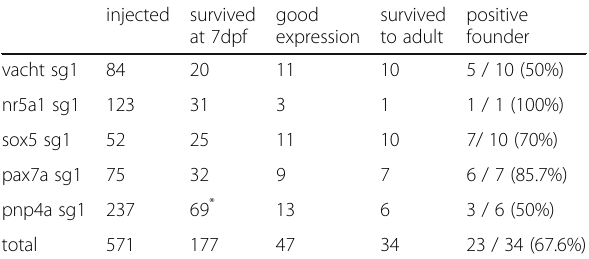
Table 2 Results of microinjections and screening of transgenic